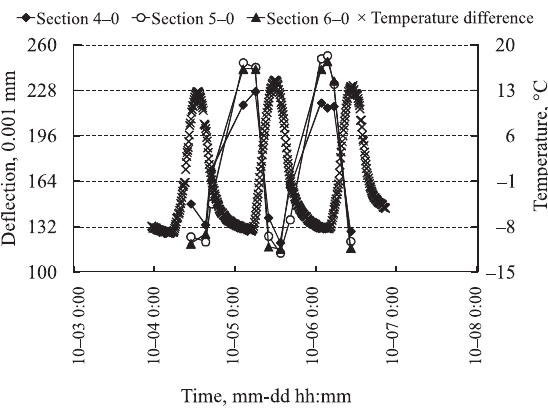
Fig. 10. Joint deflection measured at loading point